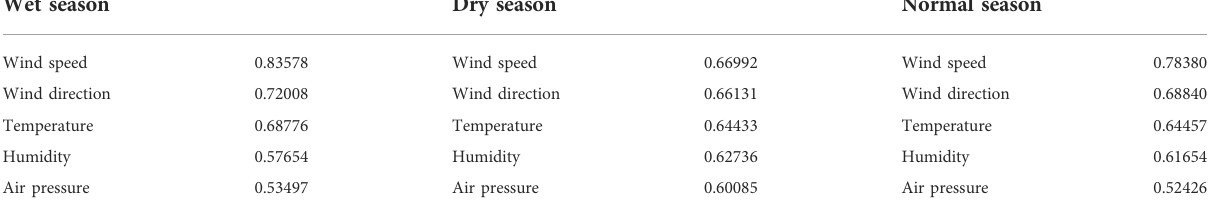
TABLE 1 Relational analysis of core meteorological factors of the wind power